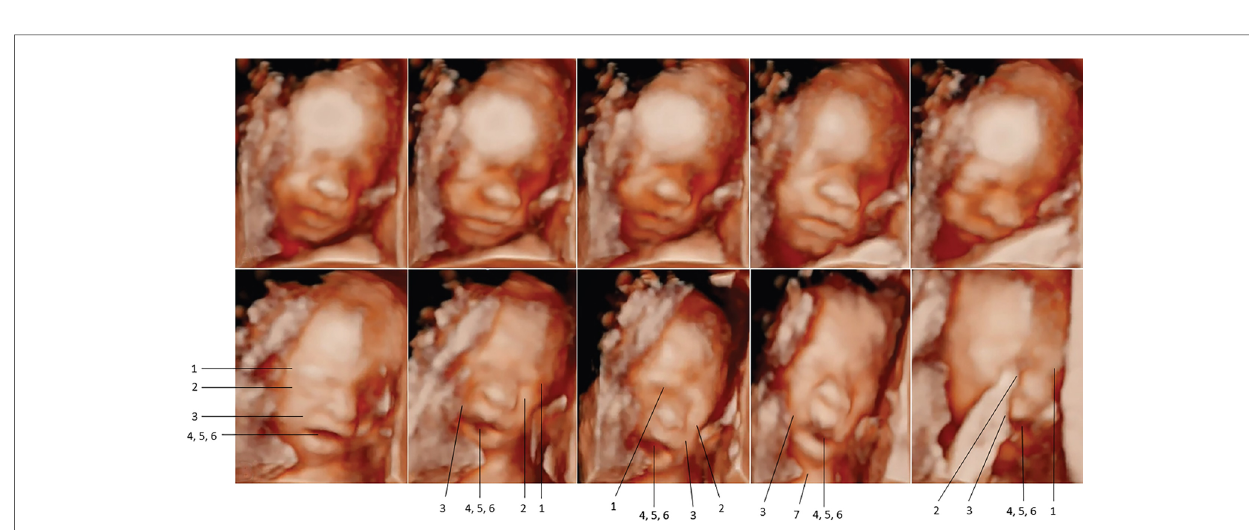
FIGURE 8 Pain-related facial expressions in 23-week fetus in response to intramuscular injection of fetal thigh, analyzed by blinded investigators (16). Four- dimenstional ultrasound images of fetal facial expressions analyzed before (upper row) and after (lower row) anesthetic puncture, demonstrating the lack of pain-related facial response before and the presence of pain-related facial expressions after the painful stimulus. Seven criteria were considered to be indicative of fetal pain response: 1, brow lowering; 2, eyes tightly shut; 3, deepening of the nasolabial furrow; 4, open lips; 5, vertical mouth stretch; 6, horizontal mouth stretch; and 7, neck